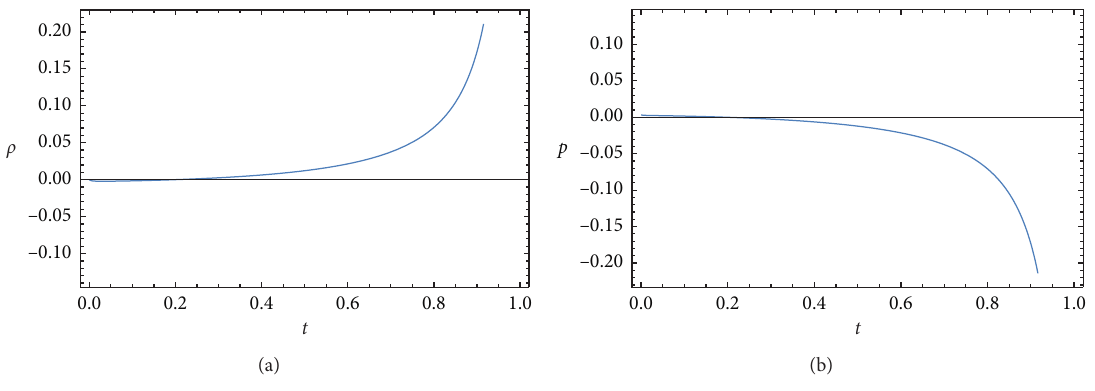
Figure 1: Energy density and pressure profiles for ω ζ � 0 . 01 ; ξ � 0 . 01 ; k � − 0 . 001 ; β � 0 . 005 ; λ � 0 . 005.